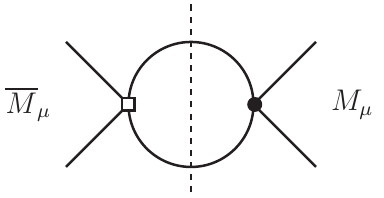
∆ L µ = 2 , while a black dot is the SM contribution of eff